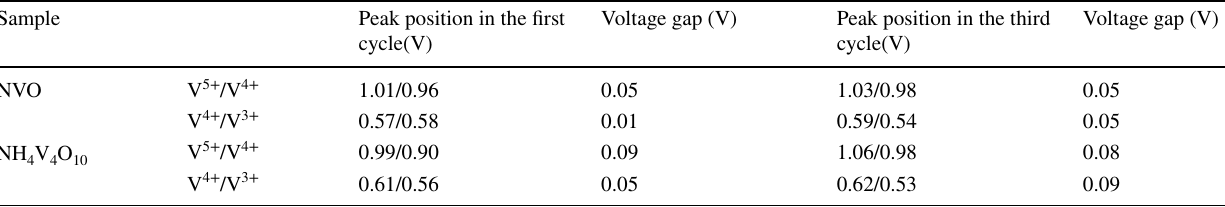
Table 1 Comparison of the peak positions and voltage gaps of three samples in the first and third cycle of CV Sample Peak position in the first